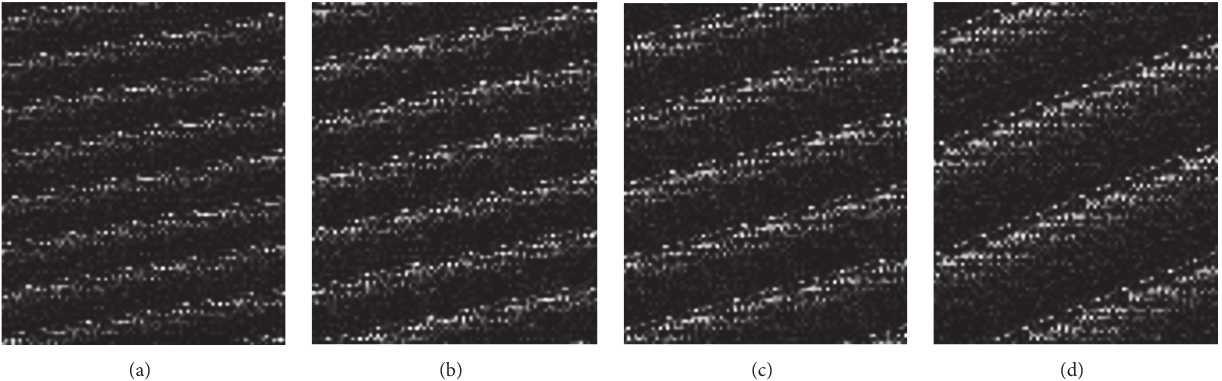
Figure 3: Vibration acceleration images for an inner race fault at (a) 1796 rpm, (b) 1772 rpm, (c) 1748 rpm, and (d) 1722